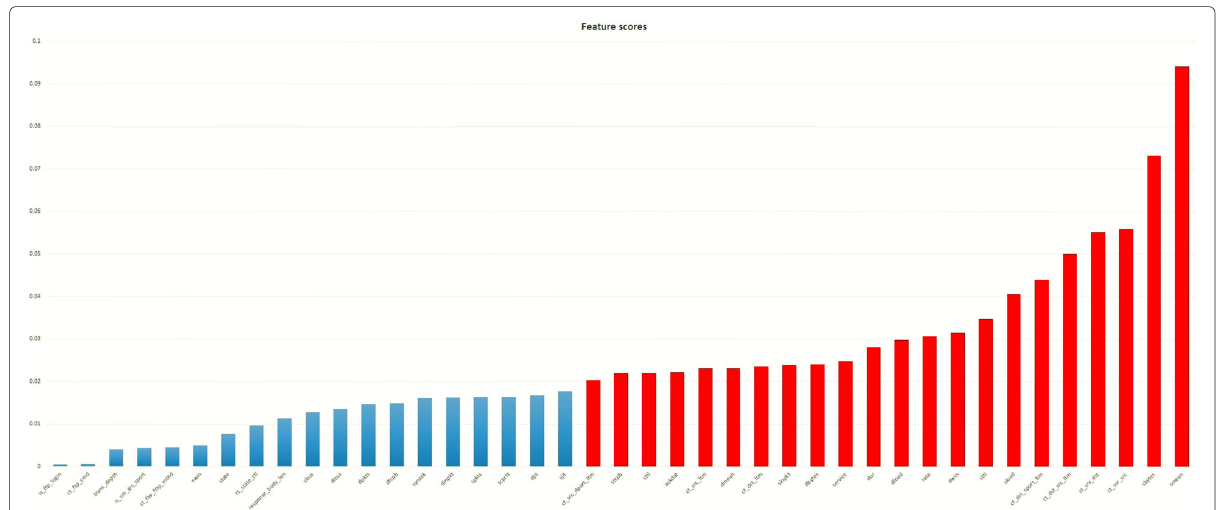
Fig. 4 Feature scores by ExtraTrees for DoS attack in the UNSW